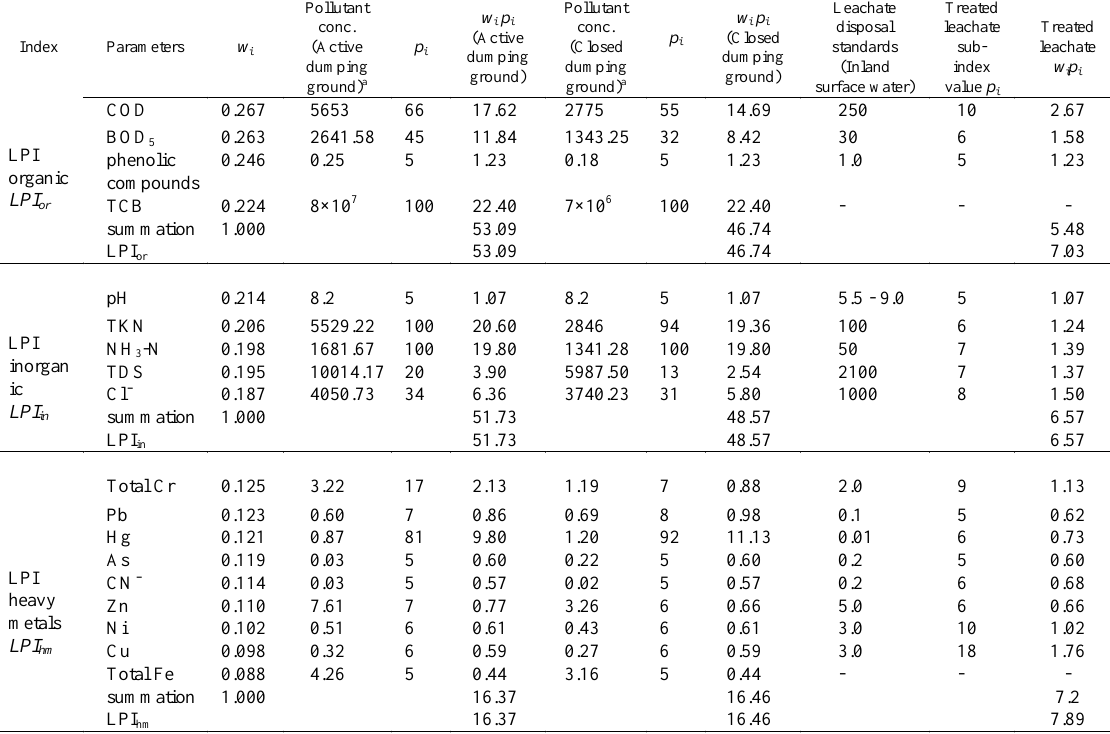
Table 3: Sub-LPI for the active and closed dumping ground in Dhapa